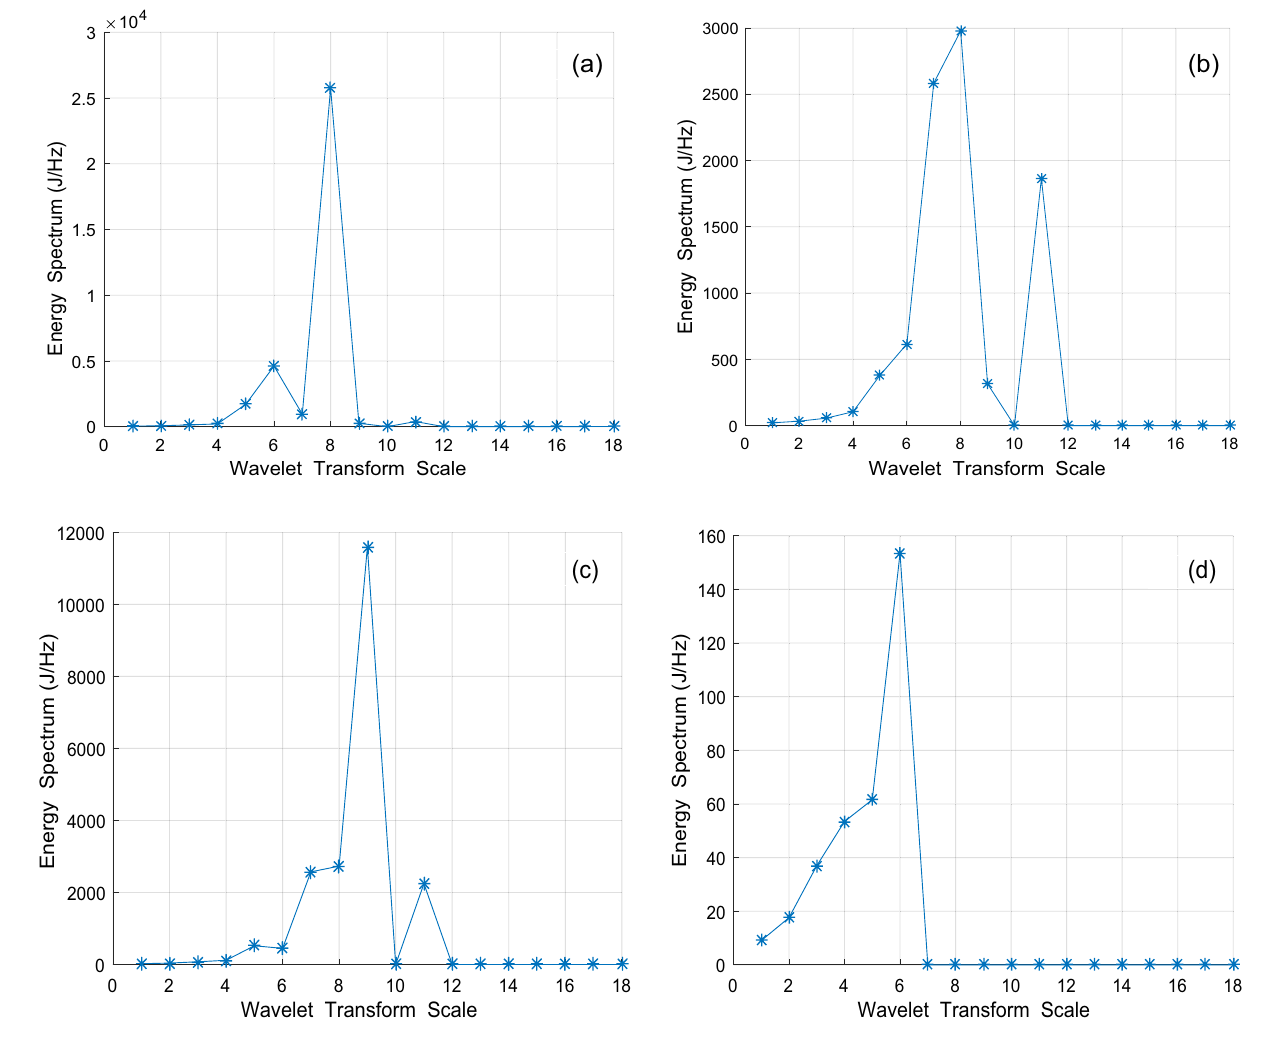
Figure 5. Multiscale wavelet energy spectrum of subgrade. ( a ) the normal subgrade; ( b ) subgrade settlement; ( c ) subgrade sinkhole; ( d ) mud